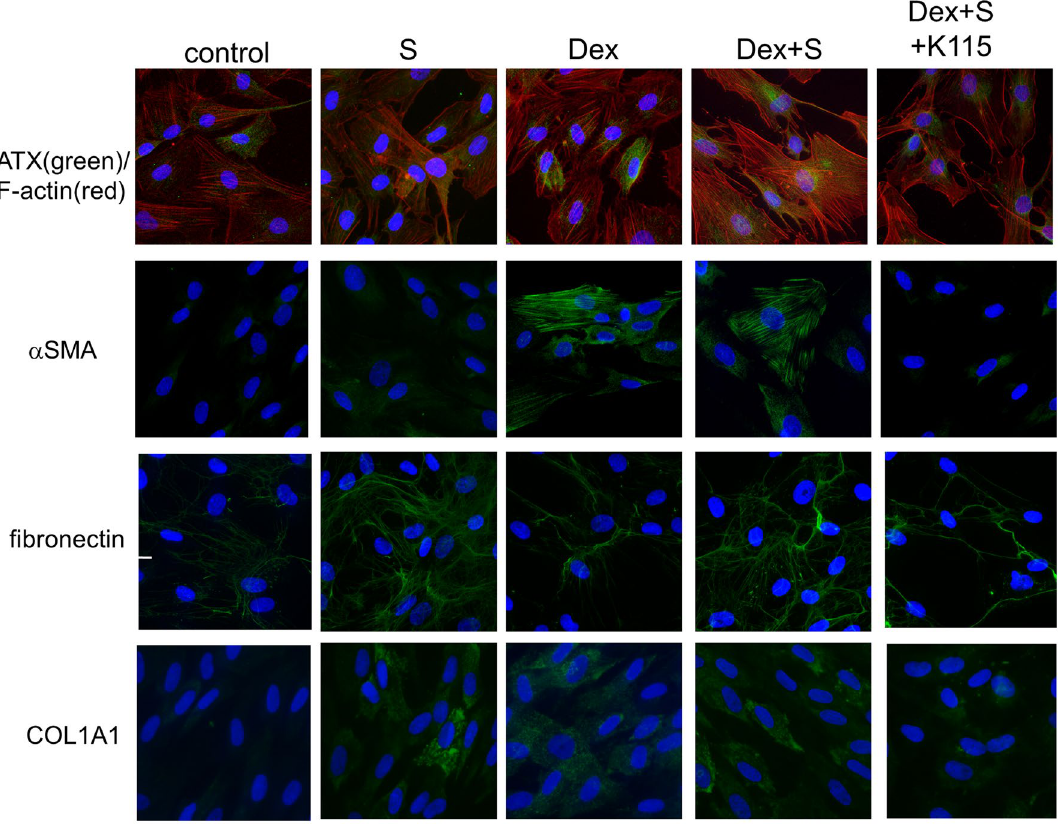
Figure 4. Immunostaining showing cellular responses in hTM cells. Immunostaining for ATX (green), nuclei/ DNA (4 ′ ,6-diamidino-2-phenylindole DAPI; blue) and F-actin (red) (upper panels) was performed in hTM cells treated with Dex (100 nM), Dex and S, or Dex + S + K115 for 24 h. Immunostaining for αSMA (green, second upper panels), fibronectin (green, third upper panels), and COL1A1 (green) (lower panels) was also conducted. Cell nuclei were counterstained with DAPI (blue). Bars, 50